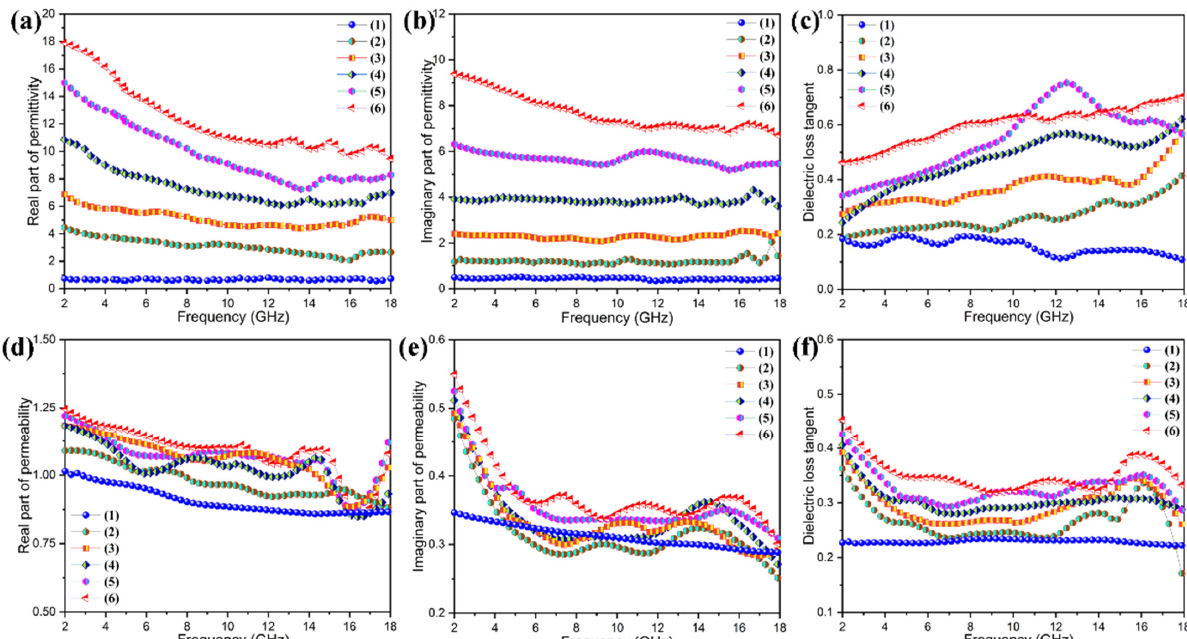
Figure 17. ( a ) Real part, ( b ) imaginary part, and ( c ) dielectric loss tangent of complex permittivity of (1) PI aerogel/PEG composite film and PI/graphene/Fe 3 O 4 hybrid aerogel films containing 5 wt% graphene nanosheets and (2) 0, (3) 2, (4) 4, (5) 6, and (6) 8 wt% Fe 3 O 4 nanoparticles. ( d ) Real part, ( e ) imaginary part, and ( f ) dielectric loss tangent of complex permeability of (1) PI aerogel/PEG composite film and PI/graphene/Fe 3 O 4 hybrid aerogel films containing 5 wt% graphene nanosheets and (2) 0, (3) 2, (4) 4, (5) 6, and (6) 8 wt% Fe 3 O 4 nanoparticles.